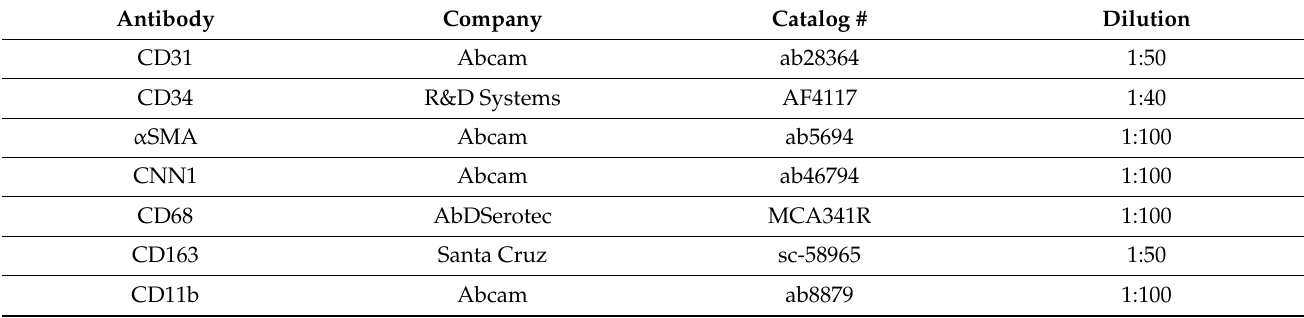
Table 1. Antibody information for